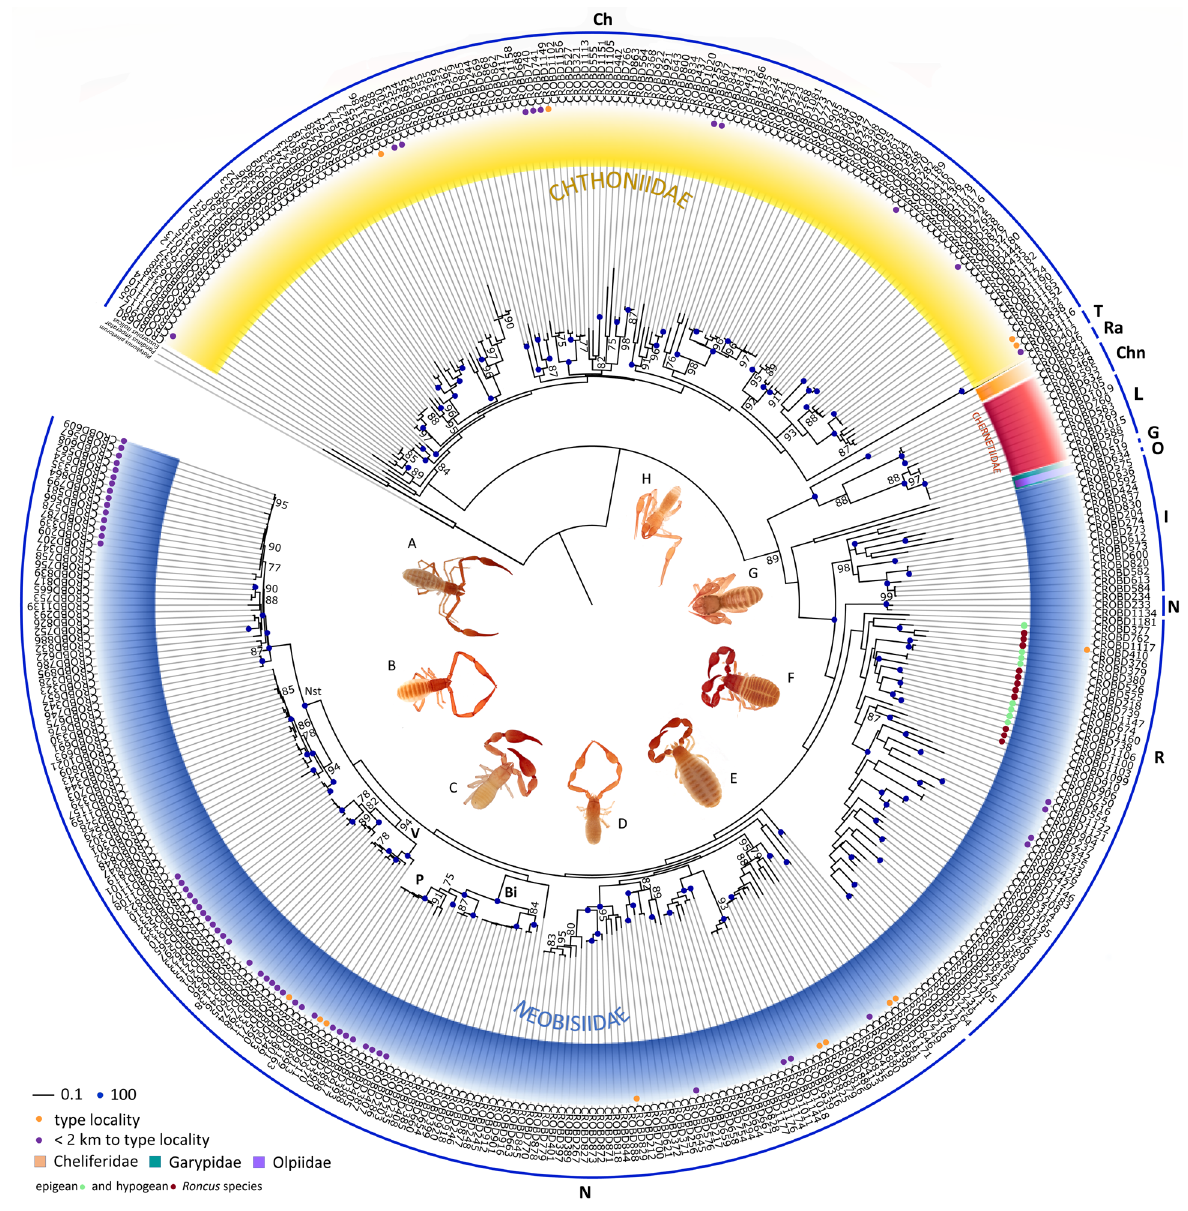
Figure 3. Circular ML tree. Species are colour-coded by family. Numbers on nodes represent ultrafast bootstrap support values (BS). Terminal codes present Sample IDs in BOLD, as in Supplementary Table 1 online. The tree was annotated in FigTree ver. 1.4.3 45 and for the circular visualization finished in iTOL ver. 5 46 and Adobe Illustrator. Representative pseudoscorpions of most recognized genera from the Dinaric Karst are shown in the middle: ( a ) Neobisium vjetrenicae Hadži (Neobisiidae), ( b ) Neobisium staudacheri Hadži (Neobisiidae), ( c ) Roncus ragusae Ćurčić (Neobisiidae), ( d ) Insulocreagris sp. (Neobisiidae), ( e ) Pselaphochernes litoralis Beier (Chernetidae), ( f ) Lasiochernes siculus Beier (Chernetidae), ( g ) Chthonius sp. (Chthoniidae), ( h ) Chthonius magnificus Beier (Chthoniidae). Different genera are represented with blue bars and labelled as: Ch ( Chthonius ), T ( Troglochthonius ), Ra ( Rhacochelifer ), Chn ( Chernes ), L ( Lasiochernes ), G ( Garypus ), O ( Olpium ), I ( Insulocreagris ), R ( Roncus ) and N ( Neobisium ). Abbreviations: P ( Protoneobisium ), Nst ( Neobisium stygium ), V (Velebit Mountain) and Bi (Biokovo